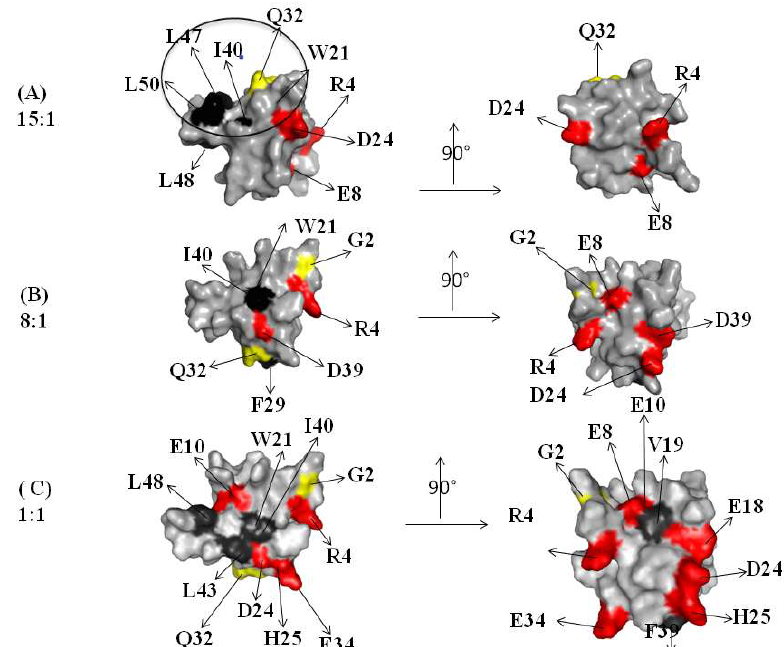
Figure 4. Graphical representation of the CUBAN surface regions that are perturbed in the interaction with NEDD8, upon increasing the molar ratio. The right panel shows a rotation of 90 degrees of the molecule. The color code of residues is the same as previously. The molar ratios are represented as follow: 15:1 ( A ); 8:1 ( B ); and 1:1 ( C ). A black circle indicates the binding surface involved in the interaction with NEDD8 [14].